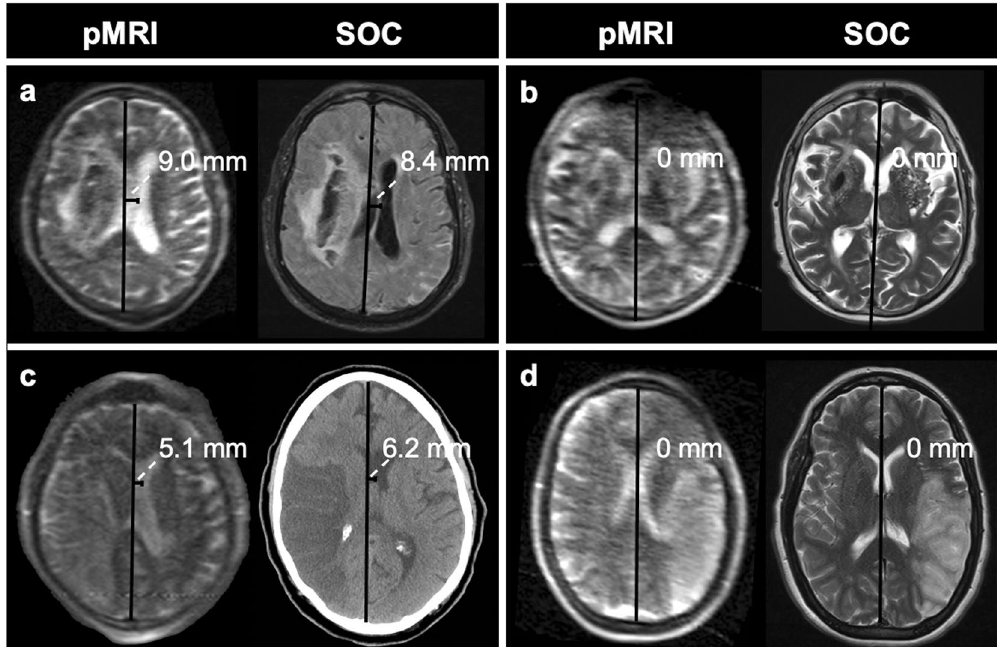
Figure 2. Example midline shift measurements on portable MRI (pMRI) and standard-of-care (SOC) imaging exams. ( a ) 81-year-old male with right intracerebral hemorrhage. Midline shift was measured to be 9.0 mm and 8.4 mm on the pMRI T2-weighted (T2W) and standard-of-care (SOC) MRI fluid-attenuated inversion recovery (FLAIR) images, respectively. ( b ) 43-year-old male with right intracerebral hemorrhage. No midline shift was measured on either pMRI T2W or SOC MRI T2W exams. ( c ) 71-year-old male with right M1 occlusion. Midline shift was measured to be 5.1 mm and 6.2 mm on the pMRI T2W and SOC CT images, respectively. ( d ) 44-year-old female with left M2 occlusion. No midline shift was measured on either pMRI T2W or SOC MRI T2W exams. Figure created using: Microsoft PowerPoint, Version 16.52, https:// www. micro soft. com/ en- us/ micro soft- 365/ power